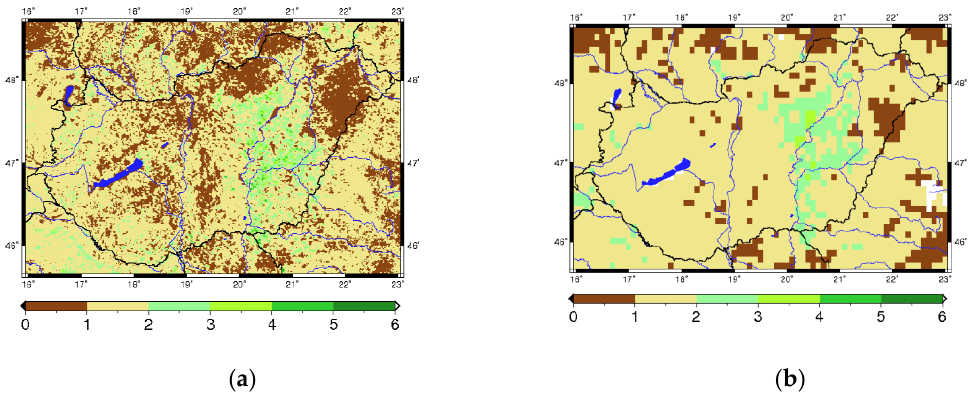
Figure 1. Raw ( a ) and extrapolated ( b ) GEOV1 Leaf area index from the Copernicus Global Land Service project on 13 April 2008.